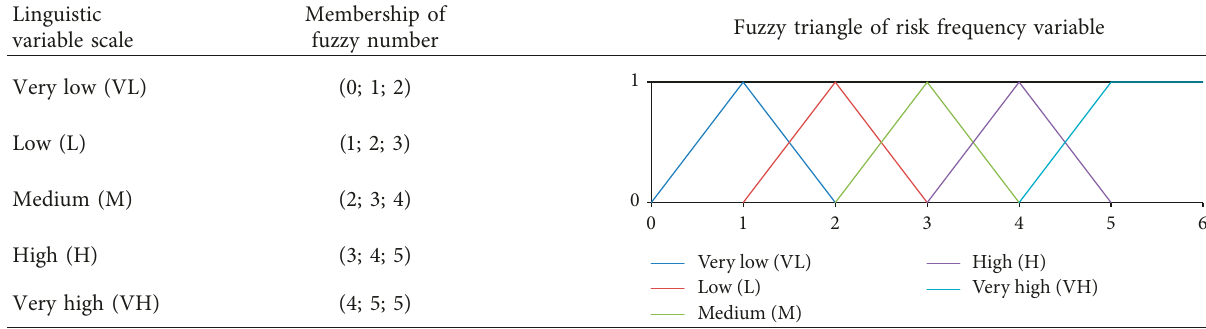
Table 1: Linguistic for the risk frequency of each risk variable.